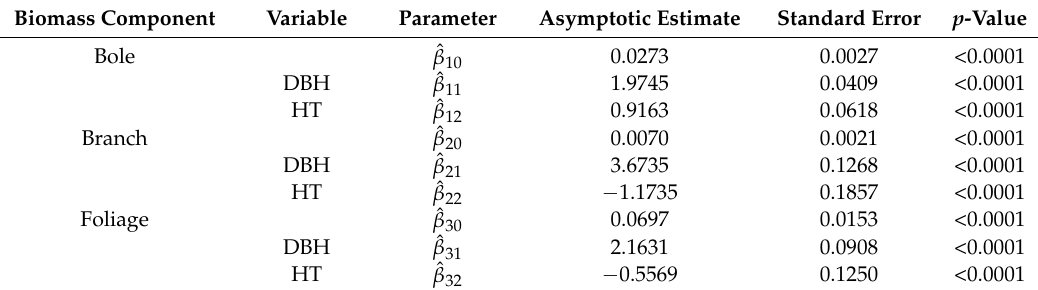
Table 4. Parameter estimates and their asymptotic standard error and p- values for the additive